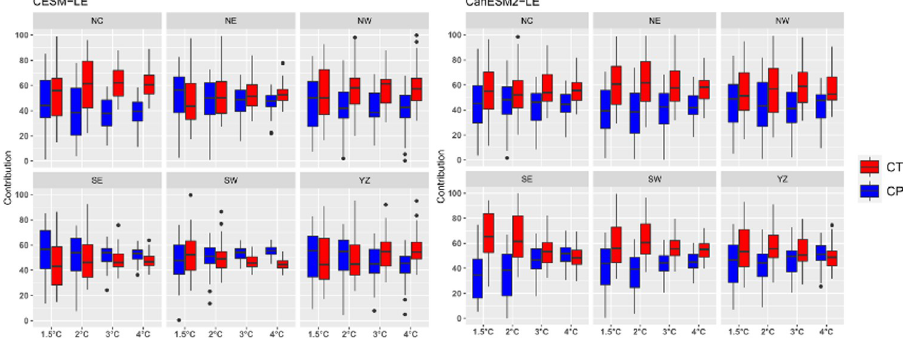
Fig 7. A boxplot of the contribution from temperature (CT) and precipitation (CP) to the changes in the SDHI in the six subregions. The upper and lower limits of the box indicate the 75th and 25th percentile values; the horizontal line in the box indicates the median; and the whiskers show the range of the